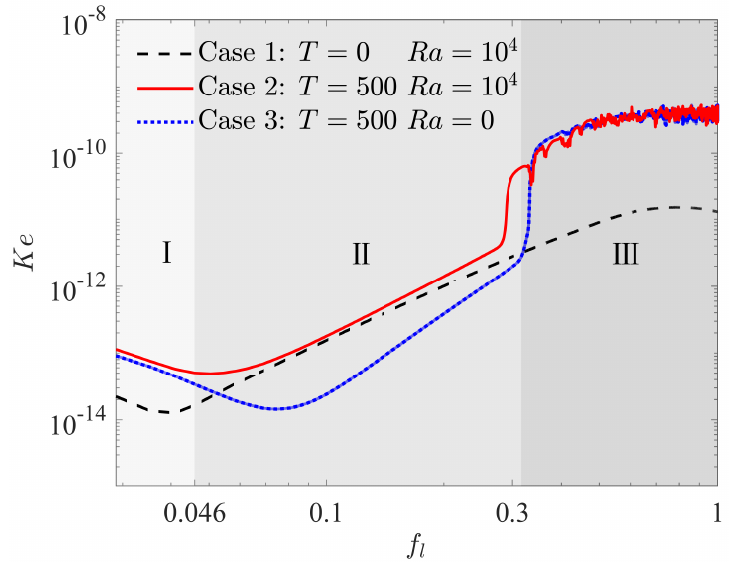
Figure 4. Kinetic energy density Ke in the fluid domain vs. total liquid fraction f l in which AR = 3/4.